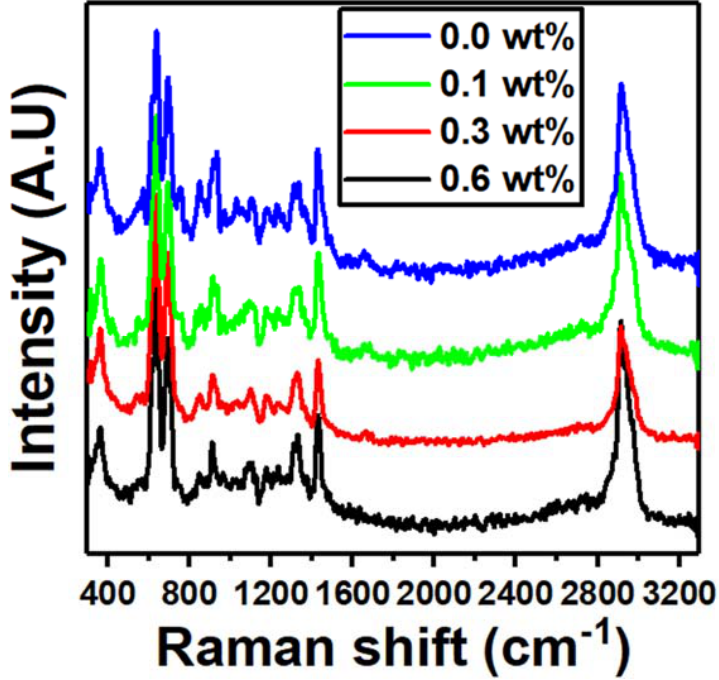
Figure 4. Raman spectra for blend nanocomposites PVC/PVP with different concentrations of Er 2 O 3.